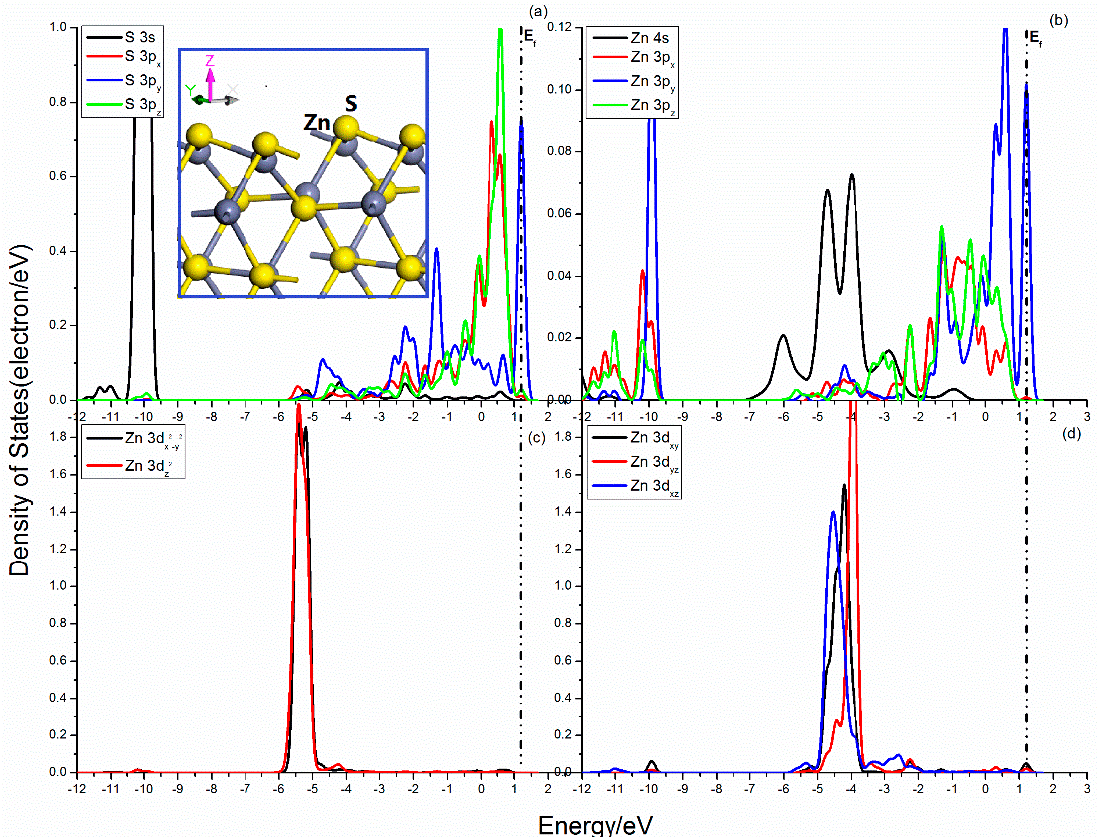
Figure 6. Projected DOSs of S and Zn of sphalerite (110) surface: ( a ) S 3s, 3p x , 3p y and 3p z states; ( b ) Zn 4s, 3p x , 3p y and 3p z states; ( c ) Zn 3d x2–y2 and 3d z2 states; ( d ) Zn 3d xy , 3d xz and 3d yz states.